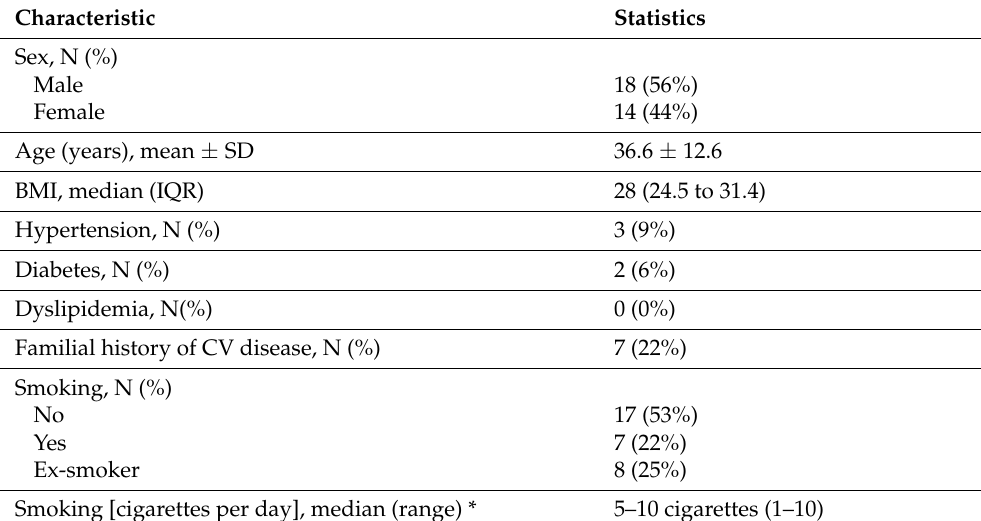
Table 1. Demographic and clinical characteristics of participants, N =